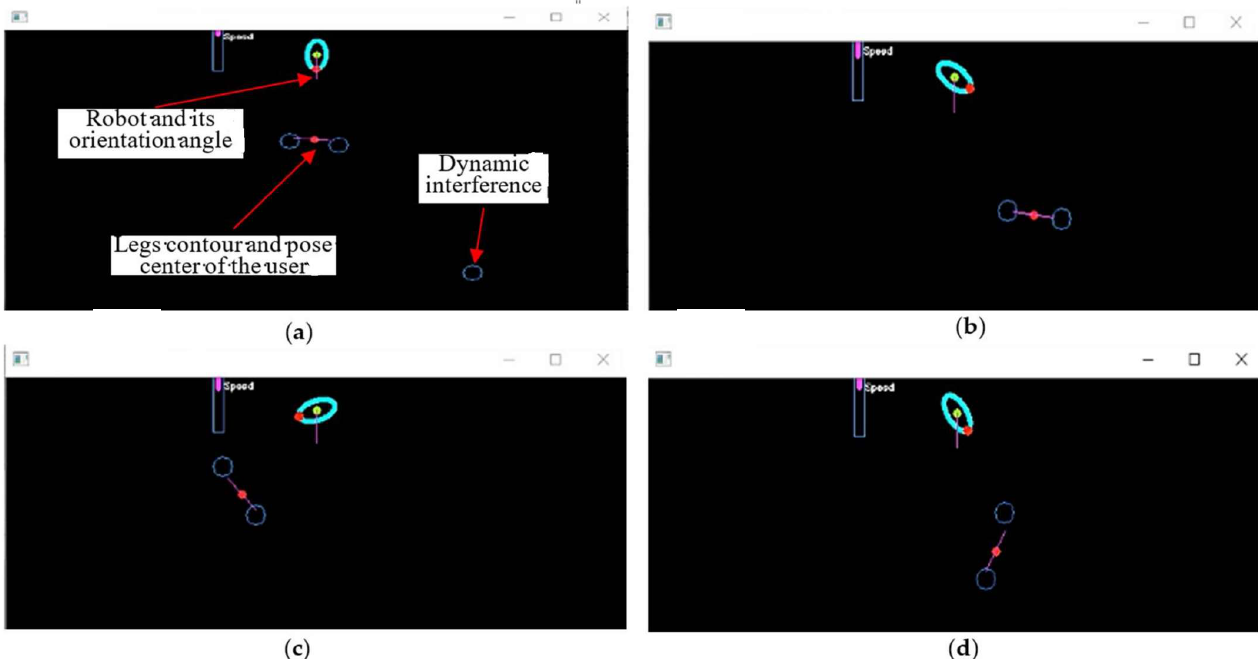
Figure 9. The legs move across each other.